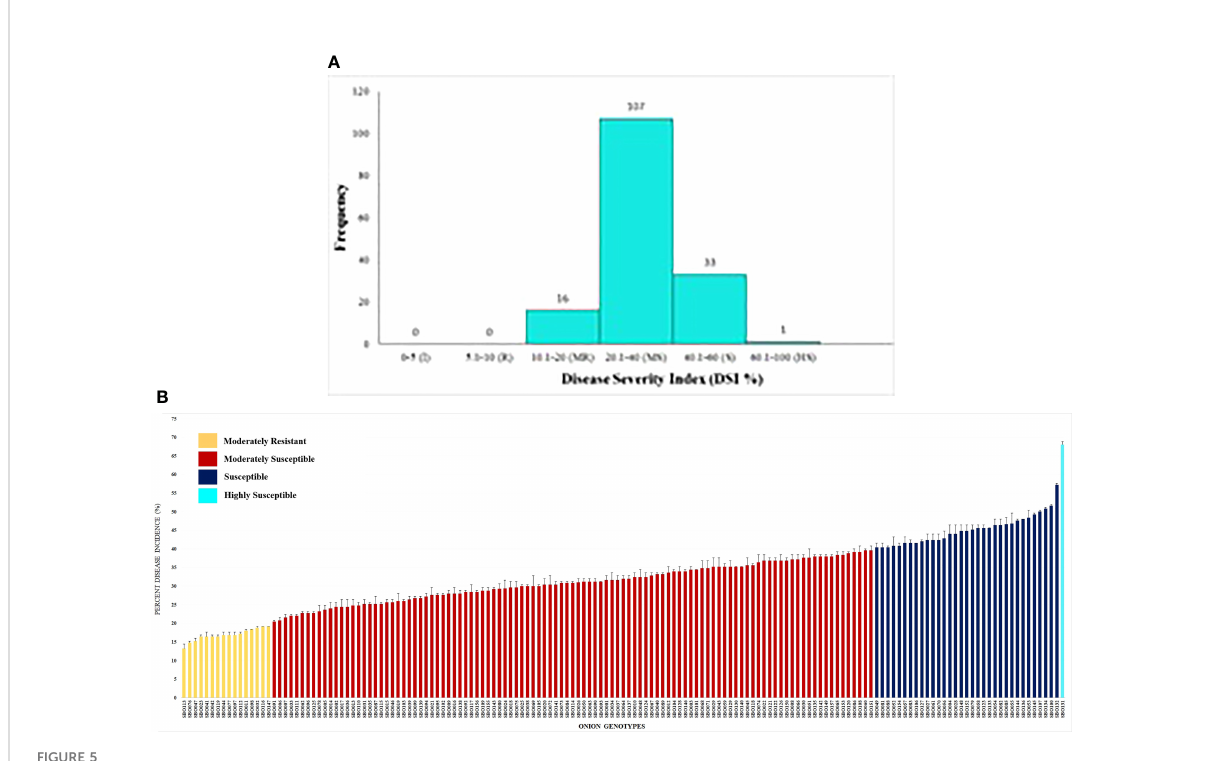
FIGURE 5 (A) Frequency distribution of onion genotypes based on percent disease incidence (PDI). (B) Reaction of onion genotypes based on percent disease incidence (PDI) to infection caused by Stemphylium leaf